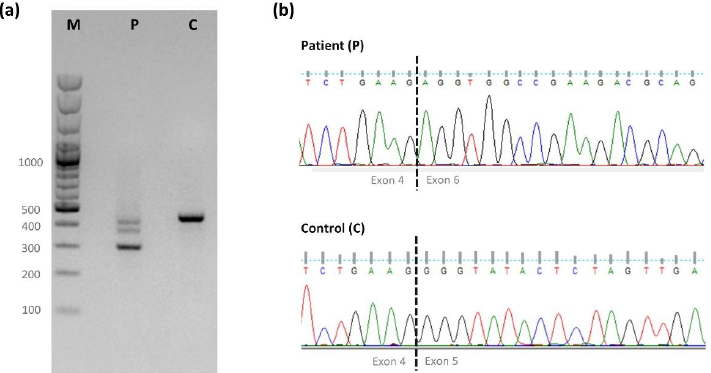
Figure 1. ( a ) Amplification products of RBM8A cDNA exons 2 to 6 (F2-II.1.) The control sample (C) shows a normal-sized fragment (~460 bp), as expected for the region encompassing exons 2 to 6. The patient (P) presents a faint, normal-sized fragment and a predominantly shorter fragment (~320bp), consistent with the absence of exon 5. The residual intermediate-sized fragment reflects heterodu- plex formation (verified by Sanger sequencing; data not shown). ( b ) Partial electropherograms showing the exon 4/exon 6 junction sequence in the patient’s aberrant fragment and the normal exon 4/exon 5 junction sequence in the control. M — size markers: GeneRuler 100bp Plus DNA ladder (Thermo Fisher Scientific, Waltham, MA, USA).